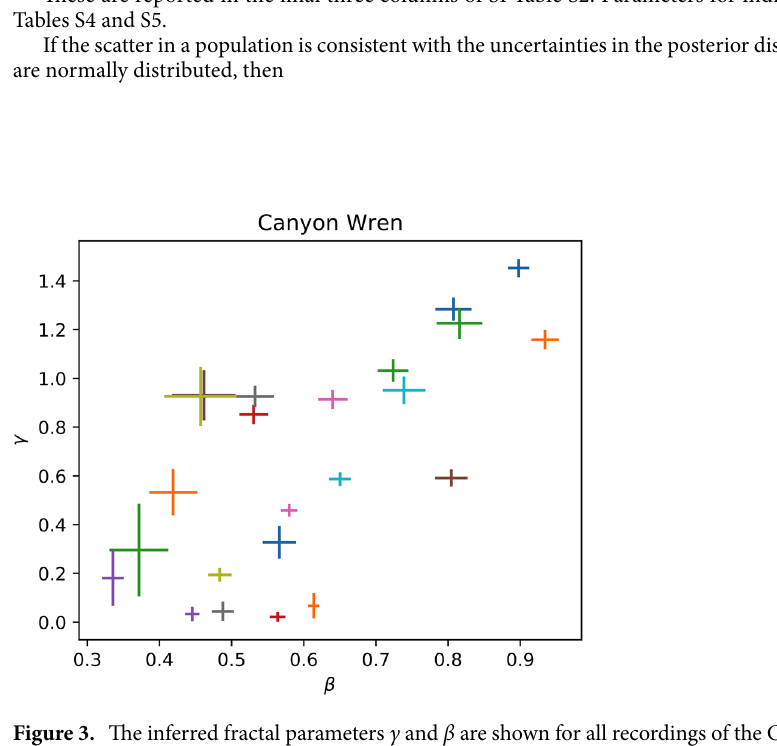
Figure 3. The inferred fractal parameters γ and β are shown for all recordings of the Canyon Wren that were analyzed. These are broadly consistent up to their